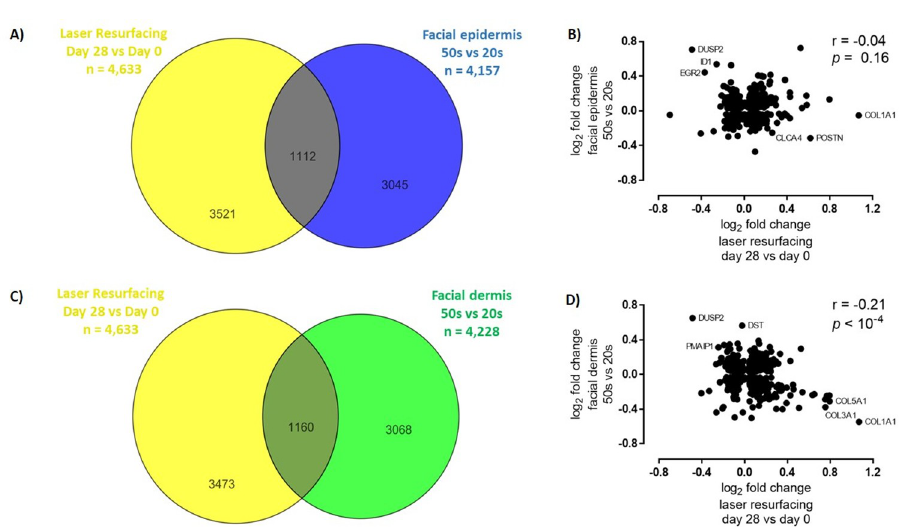
Fig 3. Laser resurfacing treatment reverses age-related gene expression changes. A) Venn diagram depicting the overlap in statistically significant genes altered at 28 days post-laser resurfacing and in facial epidermis between 50-year-olds and 20-year-olds described in Kimball et al., 2018. B) Log 2 fold change (FC) plot and Pearson correlation for the overlapping genes from A). C) Venn diagram depicting the overlap in statistically significant genes in the laser resurfacing single-treatment kinetic signature and in facial epidermis between 50-year-olds and 20-year-olds described in Kimball et al., 2018. D) Log 2 fold change (FC) plot and Pearson correlation for the overlapping genes from C).